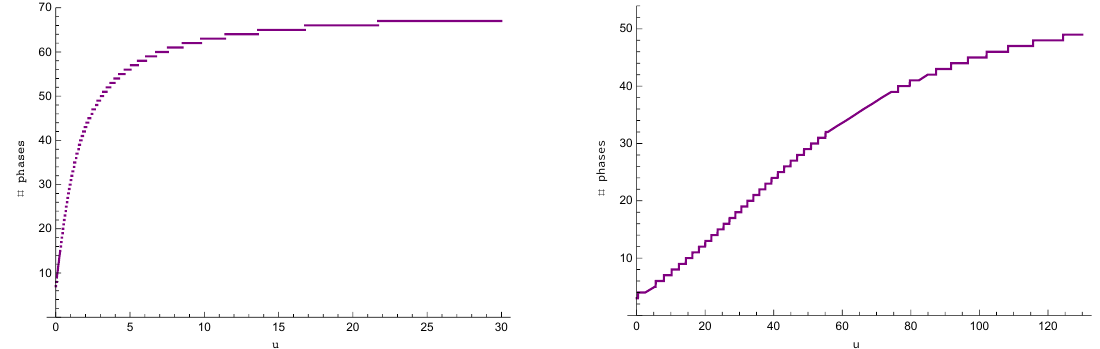
Figure 2. Number of phases required to guarantee for each initial capital u an error bound (i) δ = 0.02 under Pareto ( 2,3 ) claim sizes ( left graph ) and (ii) δ = 0.05 under Weibull ( 0.5,3 ) claim sizes ( right graph